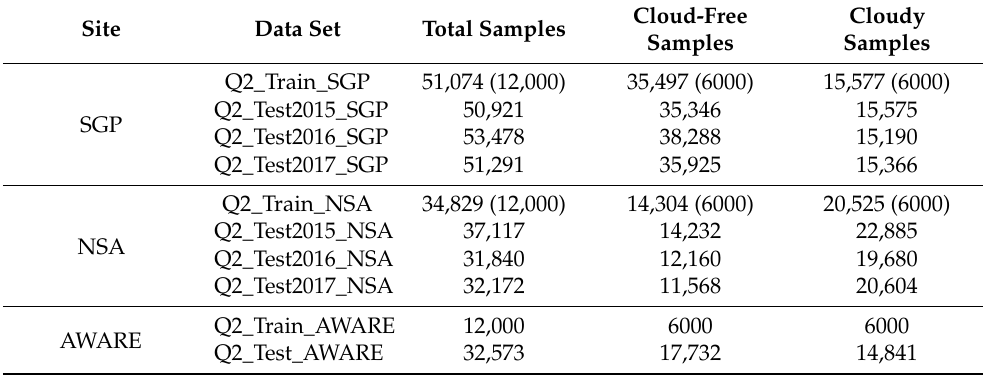
Table 2. Cloud detection database. The data in parentheses indicates 6000 groups of cloud-free samples and 6000 groups of cloudy samples of Q2_Train_SGP and Q2_Train_NSA for training after reselection.